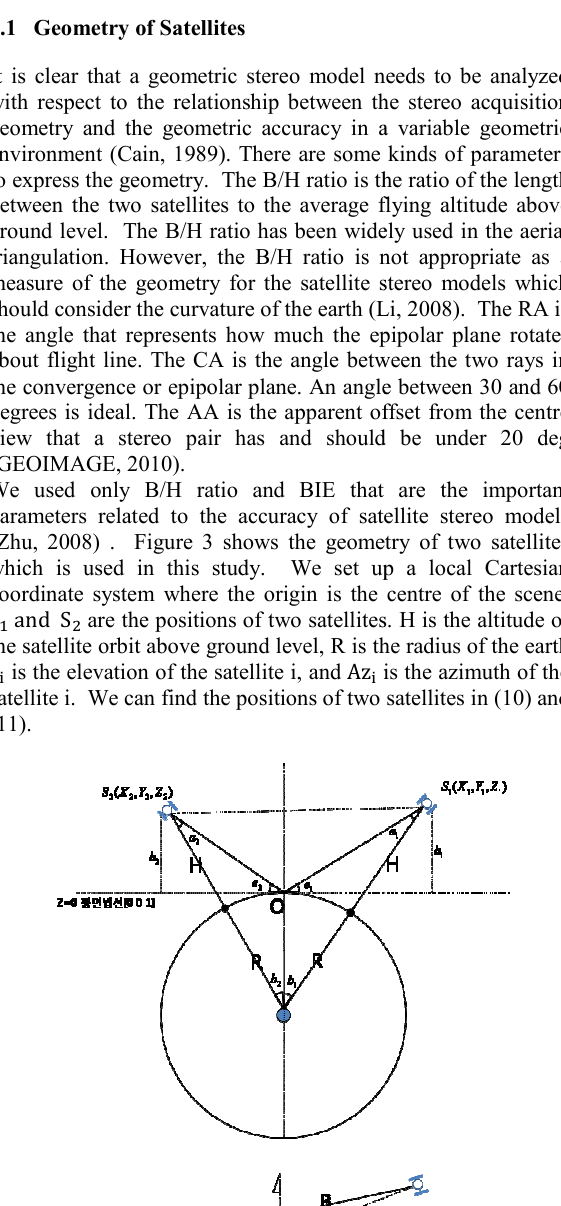
Figure 2. Image Geometry